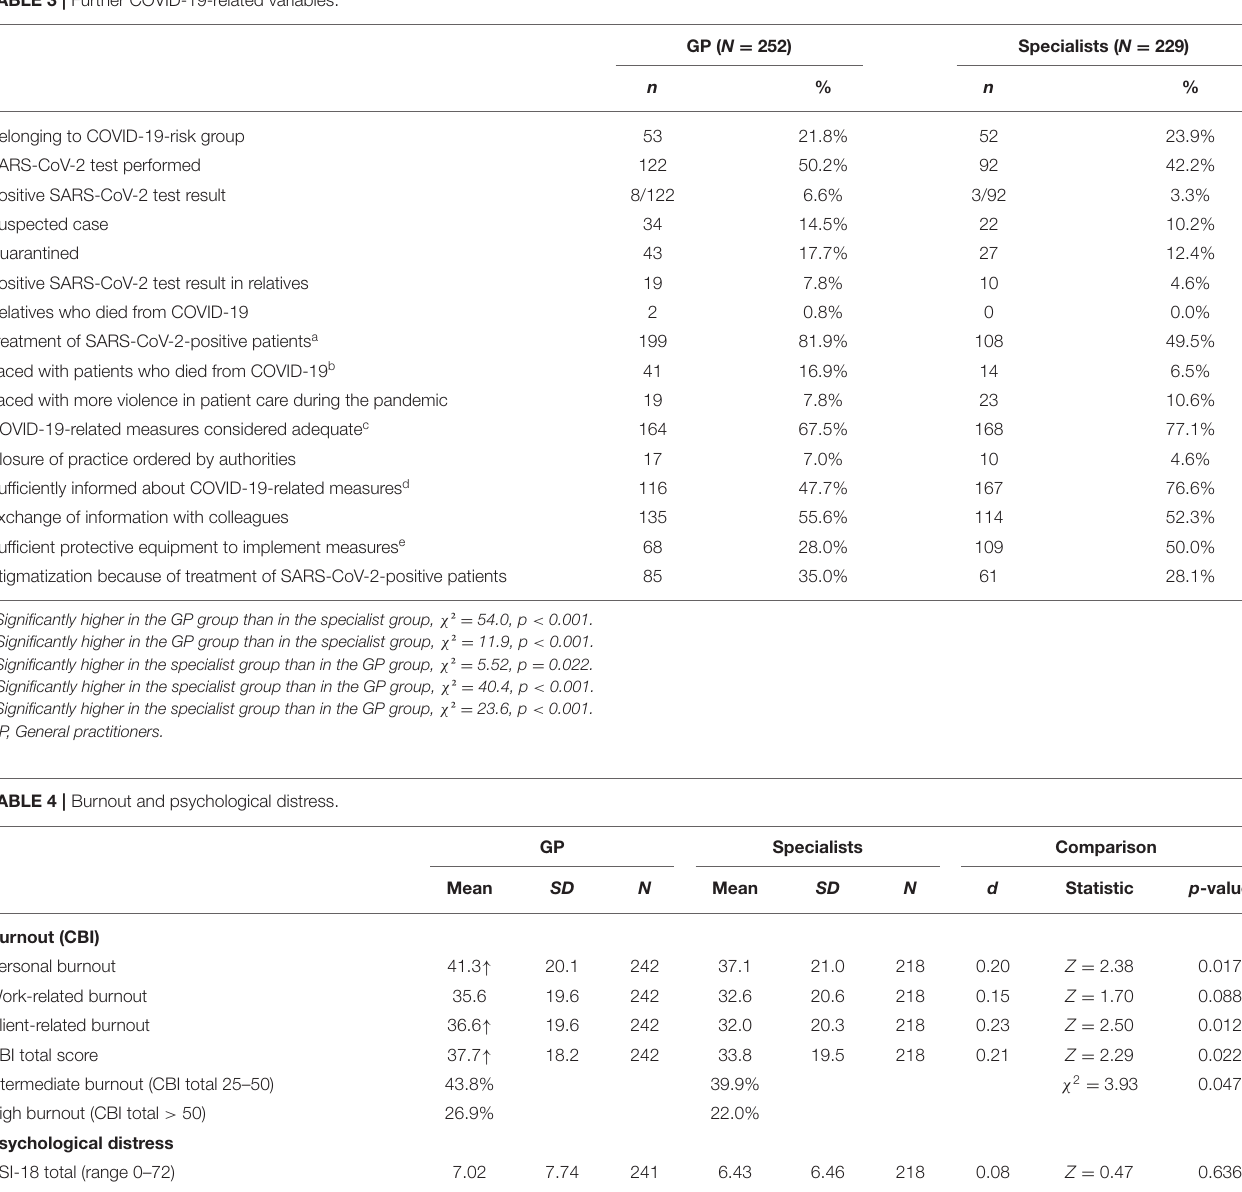
TABLE 3 | Further COVID-19-related